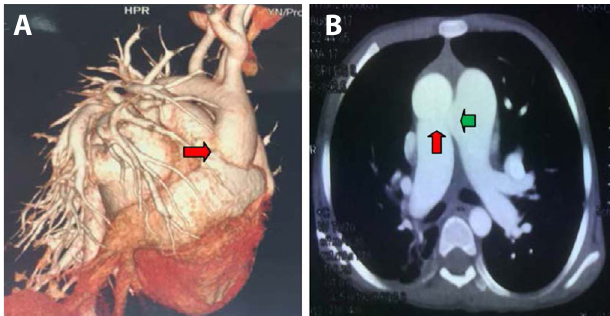
Fig. 1 – 3D reconstruction and cross-sectional map of the heart. A) Red arrow points to the right pulmonary artery originating from the ascending aorta. B) Red arrow points to the right pulmonary artery originating from the ascending aorta. Green arrow points to the aortopulmonary septal defect.